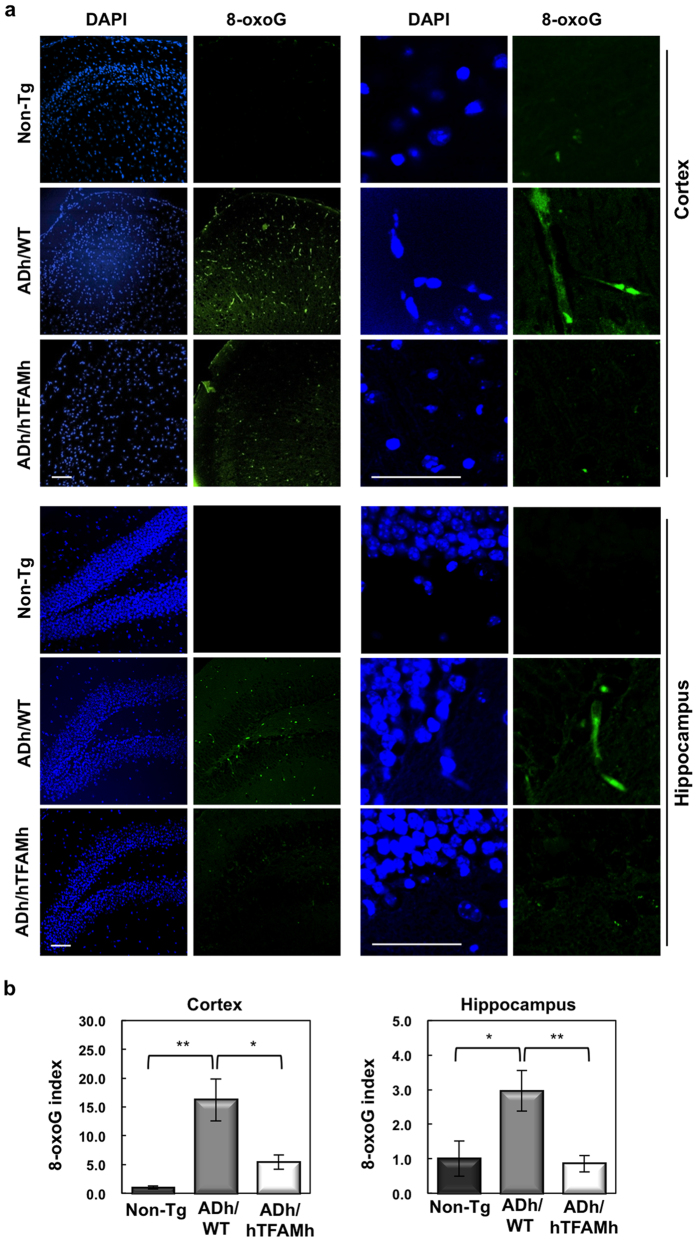
hTFAM markedly decreases accumulation of mitochondrial 8-oxoG in ADh/WT mice.(a) Immunofluorescence microscopy of 8-oxoG in cortex and hippocampus of 13–14-month-old ADh/WT and ADh/hTFAMh mice. hTFAM decreases mitochondrial 8-oxoG in the cortex and hippocampus. Scale bar, 20 μm. (b) Quantitative measurement of 8-oxoG immunofluorescence. 8-OxoG immunofluorescence was measured as described in Supplementary Fig. S3, and the relative intensity of 8-oxoG immunoreactivity (8-oxoG index) is shown in bar graphs. Cortex, one-way ANOVA, p = 0.0028. Tukey-Kramer’s HSD test: *p = 0.0193, **p = 0.0025; Hippocampus, one-way ANOVA, p = 0.0198. Tukey-Kramer’s HSD test: *p = 0.0394, **p = 0.0277. Data represent means ± SEM, n = 4.